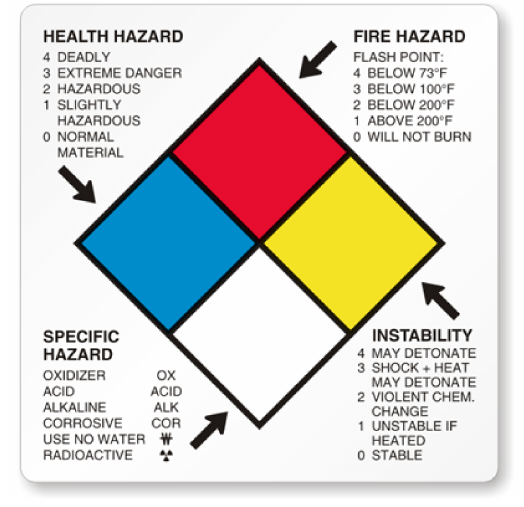
Figure 1. National Fire Protection Association (NFPA) 704 diamond standard